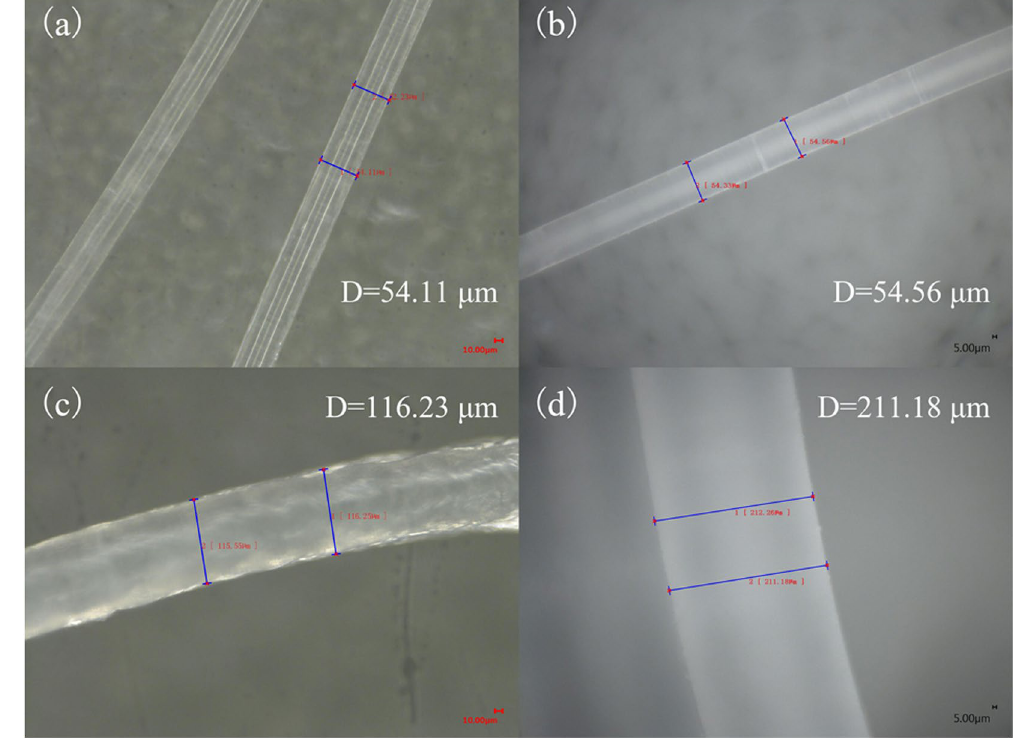
Figure 7. Ultra-depth three-dimensional microscope images of PP ( a , b ) and PP-AM-HBP-NH 2 ( c , d ) under dry (left) and moisture (right) conditions.